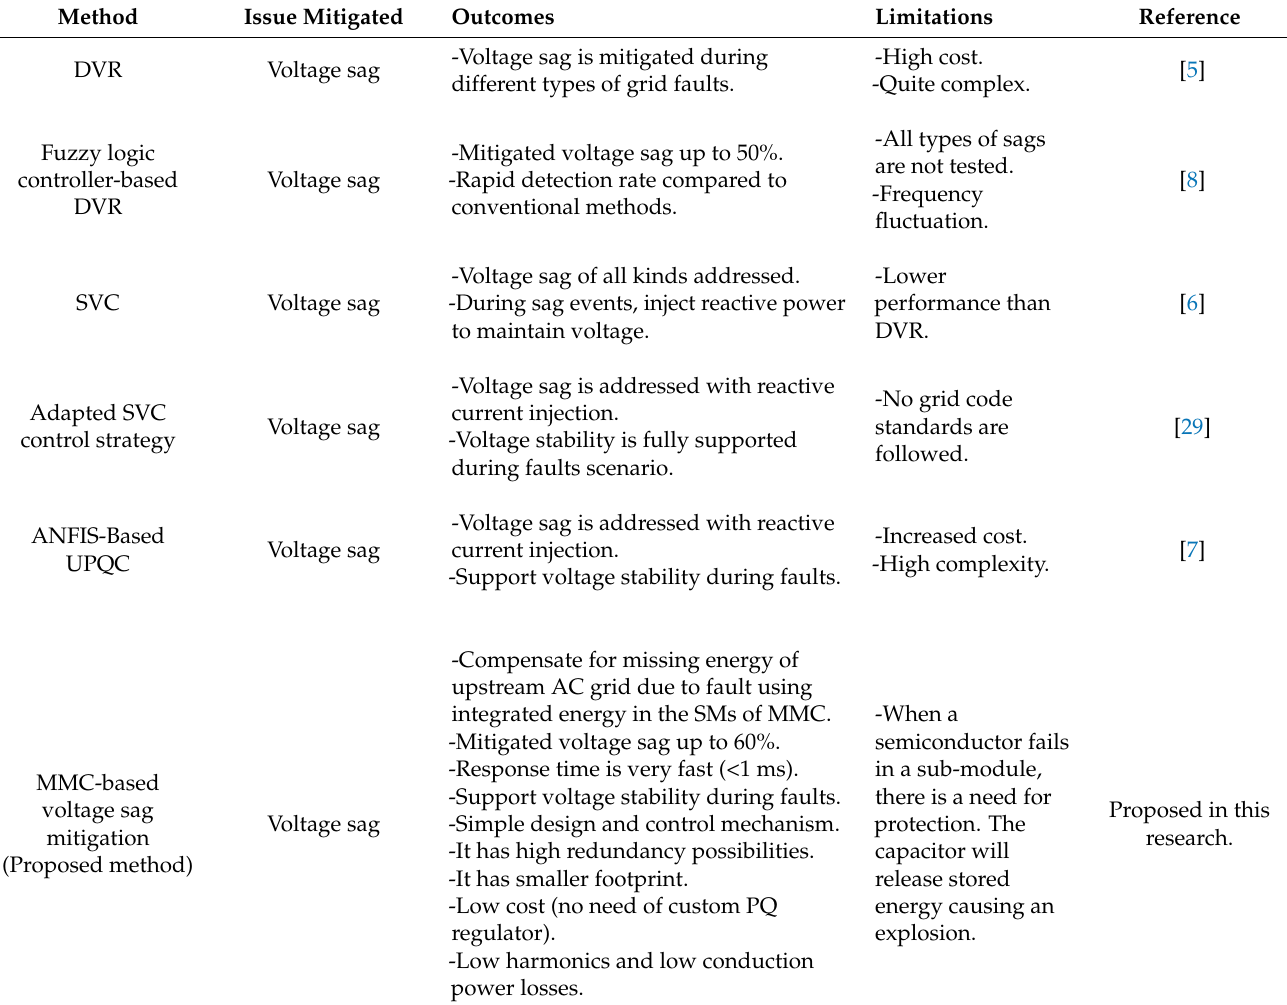
Table 5. Comparison of the commonly employed and proposed control strategies for voltage sag